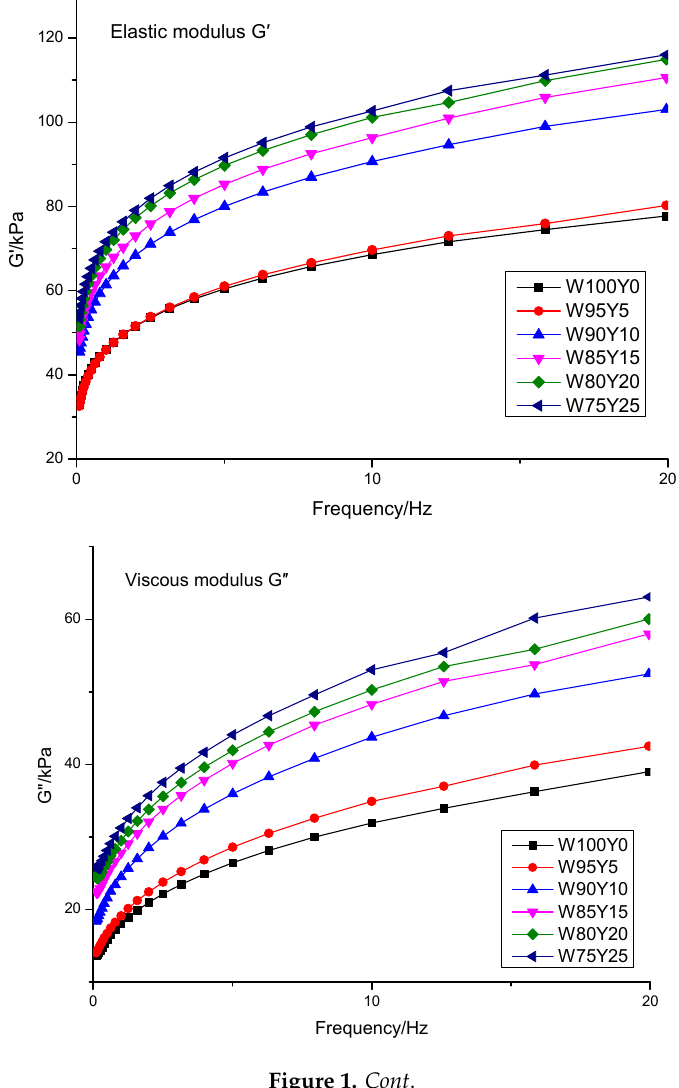
Figure 1. Cont tangent tan δ